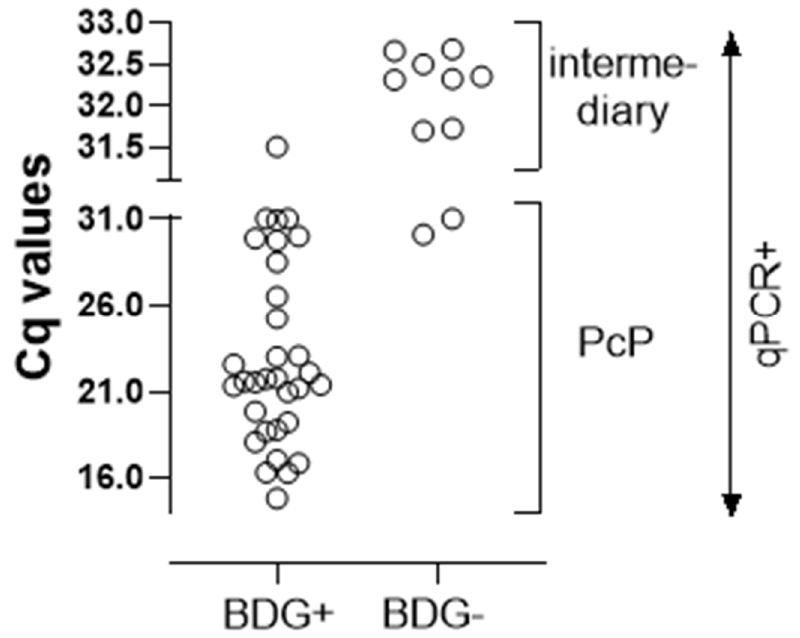
Figure 3. Comparison of the Cq values of the positive qPCR (n = 41) performed in IS with the serum 1,3-beta-d-glucan assay of patients with AIDS and suspected PcP. Each symbol represents one pa- tient.